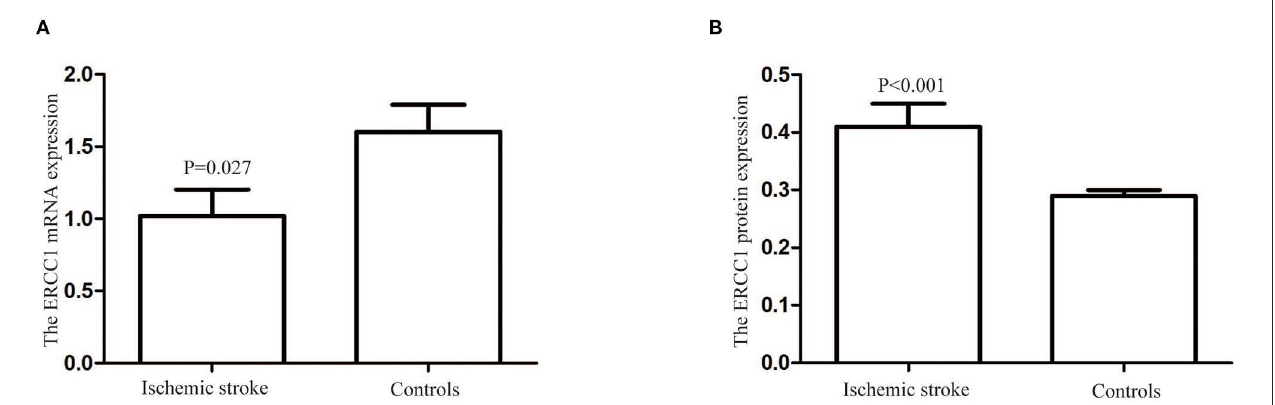
FIGURE1 The ERCC1 mRNA and protein levels in patients with ischemic stroke and controls. (A) The ERCC1 mRNA relative expression level in patients with ischemic stroke was lower than in the controls ( P = 0.027). (B) The ERCC1 protein levels in patients with ischemic stroke were higher than in the controls ( P < 0.001).